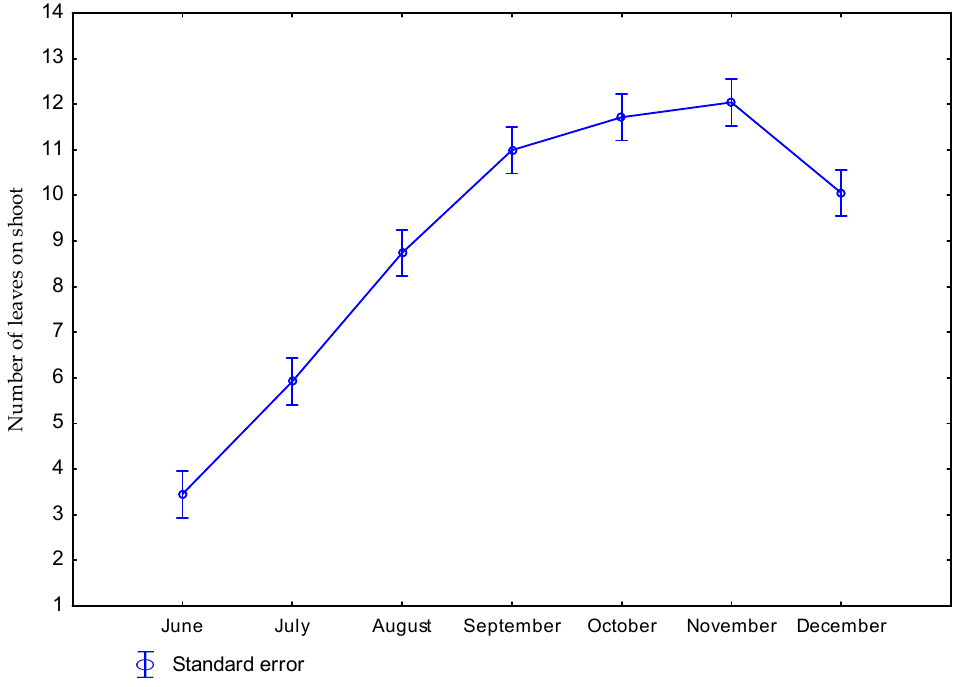
Figure 4. Number of leaves on the shoots during the vegetation period in the years 2014–2016 (average for years).